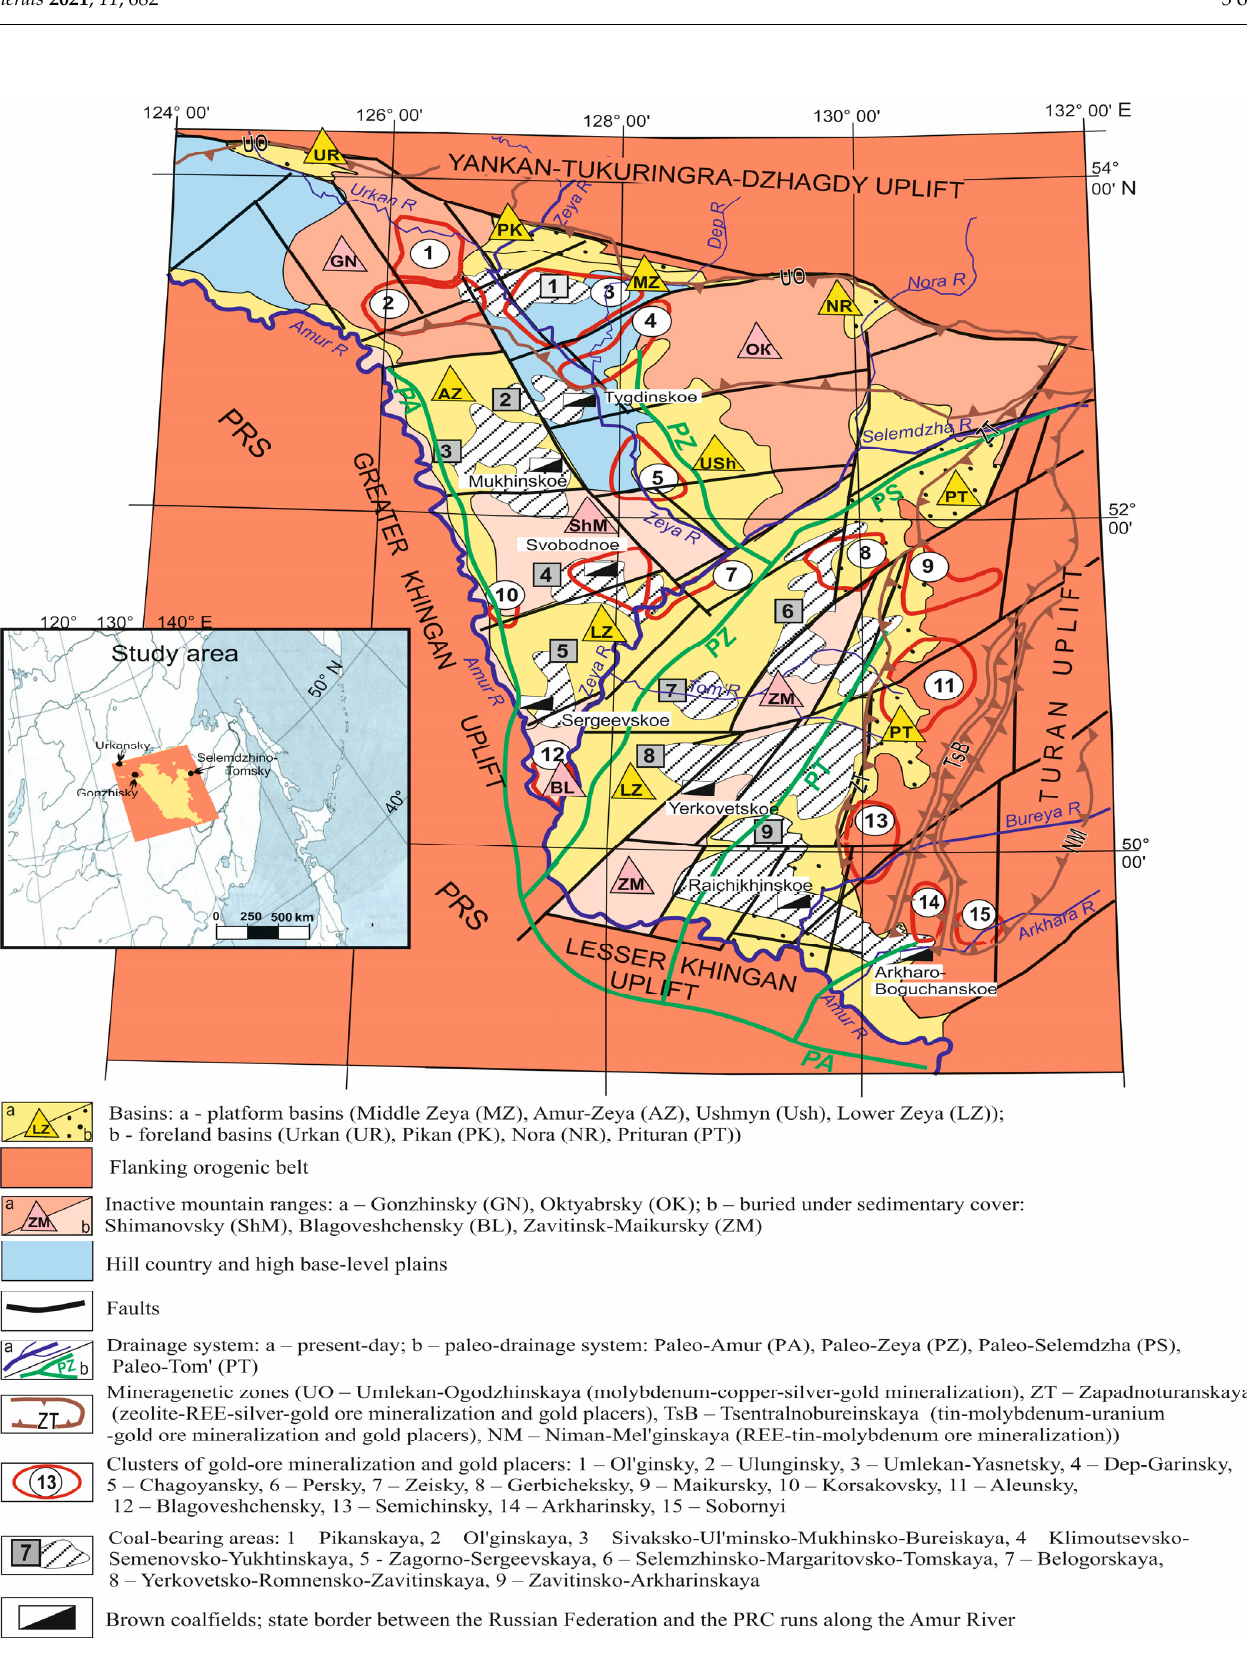
Figure 1. Schematic tectonostructural map of the Zeya–Bureya sedimentary basin [20]. The gold placers are spatially associated with coal-bearing areas of the same age along the residual mountain massifs, whereas along the periphery of the eastern mountain-fold frame, they are separated by zones of predominantly alluvial–proluvial